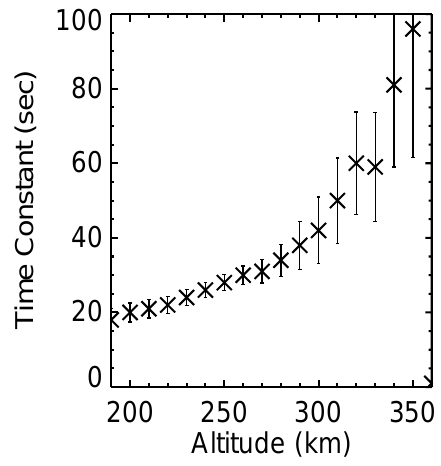
Fig. 6. Effective emission lifetimes for the O ( 1 D) 630.0nm emis- sion as a function of altitude as determined by fitting the red-line data from Fig. 5 to a